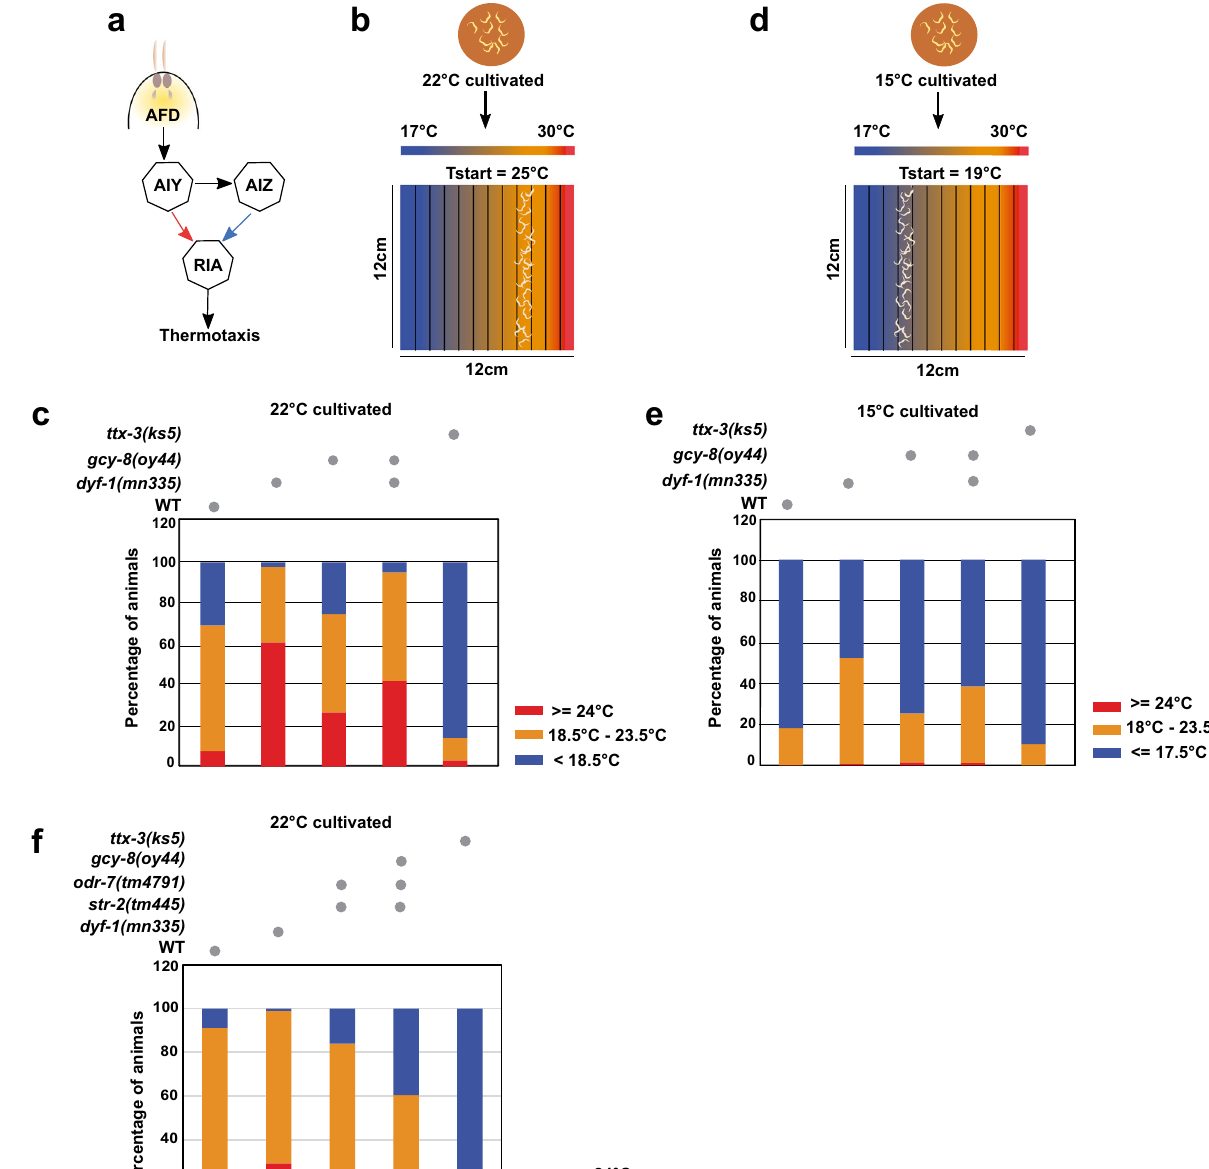
Fig. 6 | dyf-1(mn335) mutant exhibits impaired thermotaxis behaviour. a A simpli fi ed model of thermotaxis neural circuit. Temperature is sensed by the thermosensory neuron AFD. The AIY-RIA and AIZ-RIA circuit promotes the move- ment of animals to a higher temperature (thermophilic behaviour) and lower (cryophilic behaviour)temperaturethanthe cultivationtemperature, respectively. The RIA interneuron integrates the thermal signals and drives thermotaxis beha- viour. b The linear thermal gradient setup established on a 12*12cm agar surface. Tstart indicates the temperature at which the animals were placed on the linear gradient after they were cultivated at 22°C. c Negative thermotaxis behaviour of animals cultivated at 22°C after 60min are shown. The percentage distribution of animals in the speci fi ed temperature ranges are indicated. Number of animals are WT 552, dyf-1(mn335 ) 1117, gcy-8(oy44) 759, dyf-1(mn335); gcy-8(oy44) 810 and ttx-